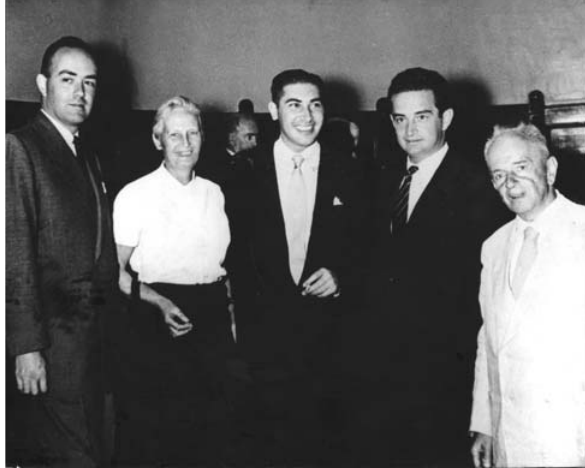
Figure 3 - From left to right: Antonio Brito da Cunha, Marta Erps Breuer, Juan Nacrur, Crodowaldo Pavan, Theodosius Dobzhansky, probably dur- ing the sessions of Pavan’s Cathedra examination held on April 6-10 th , 1953, in the Main Building of the Faculdade de Filosofia, Ciências e LetrasdaUniversidadedeSãoPaulo (thenatRuaMariaAntonia294,São Paulo City (SP),